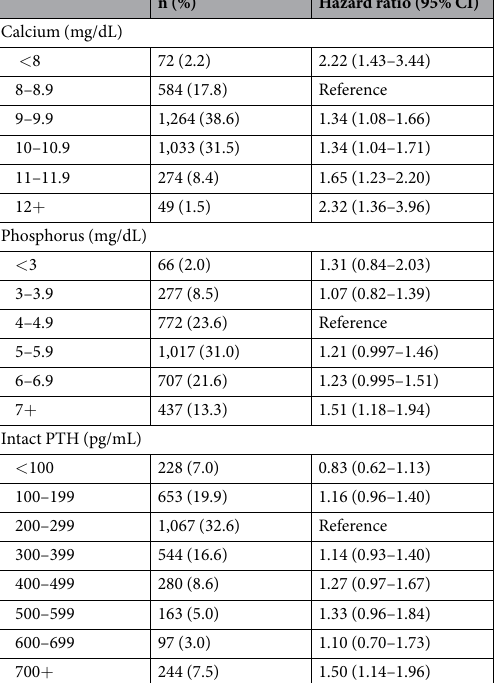
Table 2. Association of mortality with calcium, phosphorus and intact PTH. Adjusted for age, sex, dialysis duration, serum albumin, cardiovascular disease, hypertension, diabetes mellitus, cancer, single-pool Kt/V and body mass index. CI, confidence interval; PTH, parathyroid